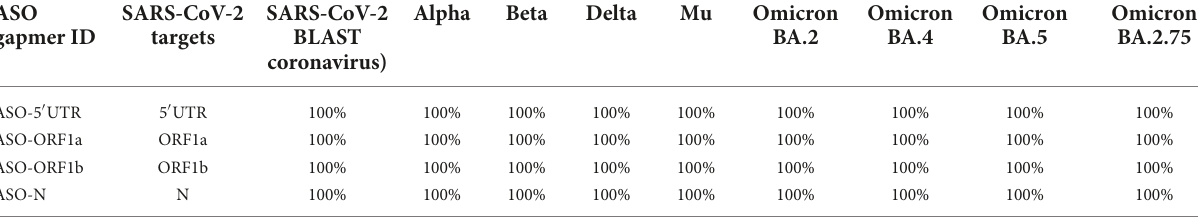
TABLE 2 Alignment of the four selected ASO gapmers with SARS-CoV-2 variants of concern (VOCs). ASO SARS-CoV-2 SARS-CoV-2 Alpha gapmer ID targets BLAST coronavirus)